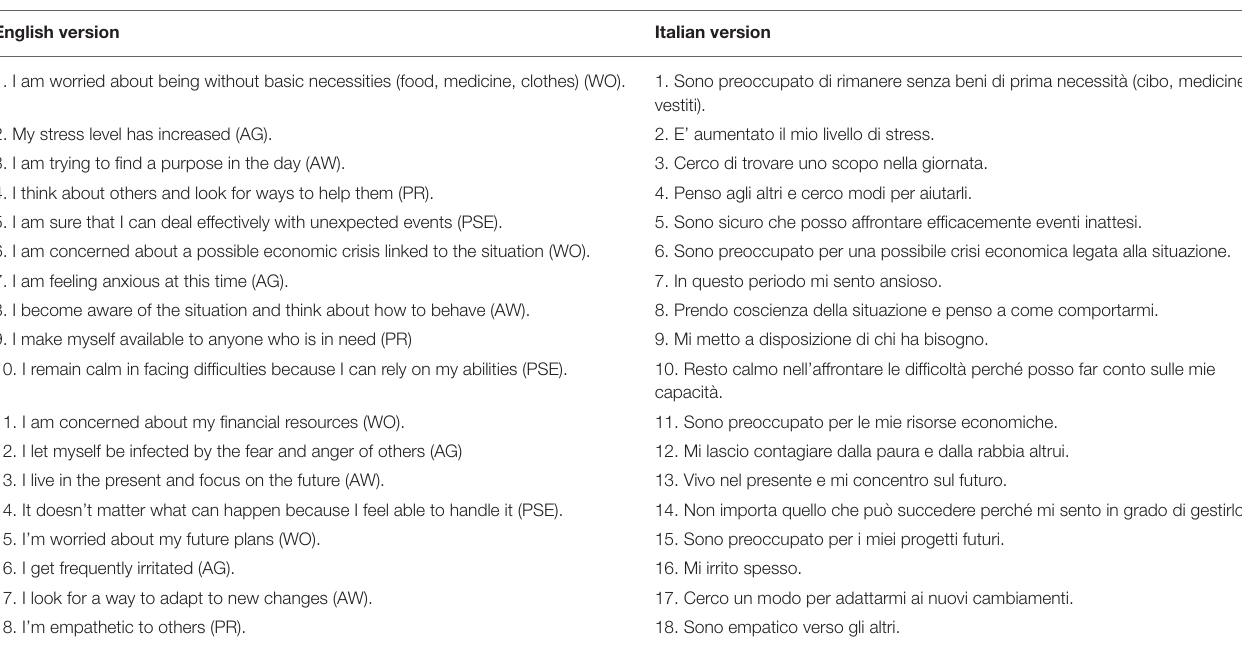
TABLE 7 | Emergency Response and Psychological Adaptation Scale